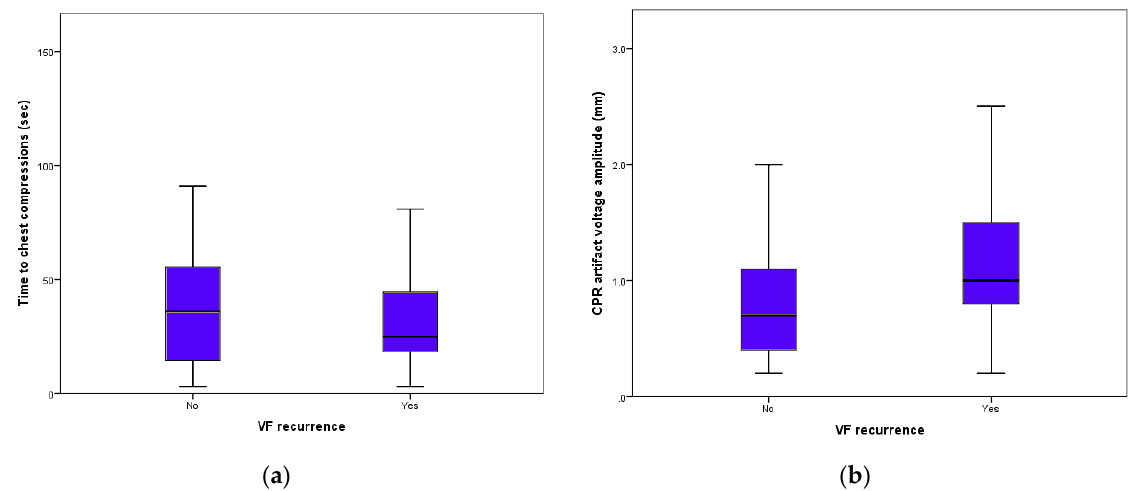
Figure 5. Time from shock to start of chest compressions ( a ) and chest-compression artifacts height ( b ) according to the presence or absence of VF re-induction.